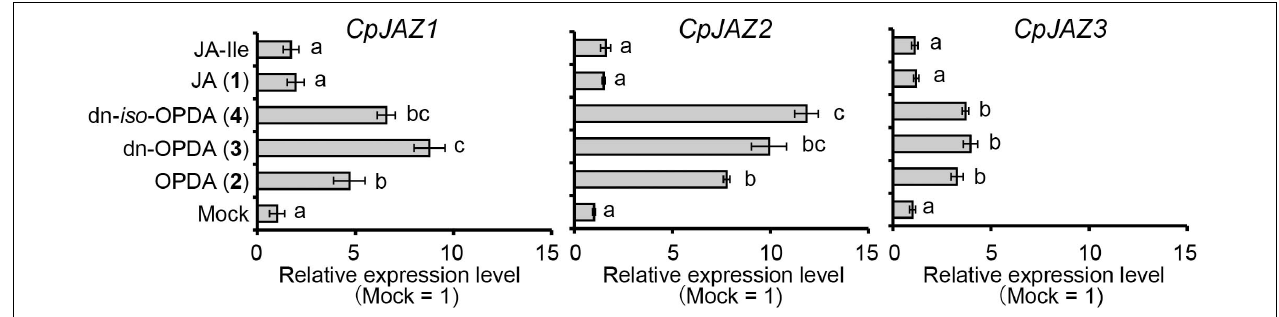
FIGURE 5 | Effect of wounding on the expression of CpJAZ1 , CpJAZ2 , and CpJAZ3 as determined by qRT-PCR. Values indicate relative expression levels after treatment with OPDA, dn-OPDA, dn- iso -OPDA, JA, and JA-Ile at 50 µ M ( n = 3). Mock samples were treated with BCDATG liquid media containing 0.5% (v/v) dimethyl sulfoxide as a negative control. Expression levels were normalized to the expression of CpACT3 , and the bars indicate the standard errors of the means. Statistically different data groups are indicated with different letters ( p < 0.05, one-way ANOVA with Tukey’s post hoc test).